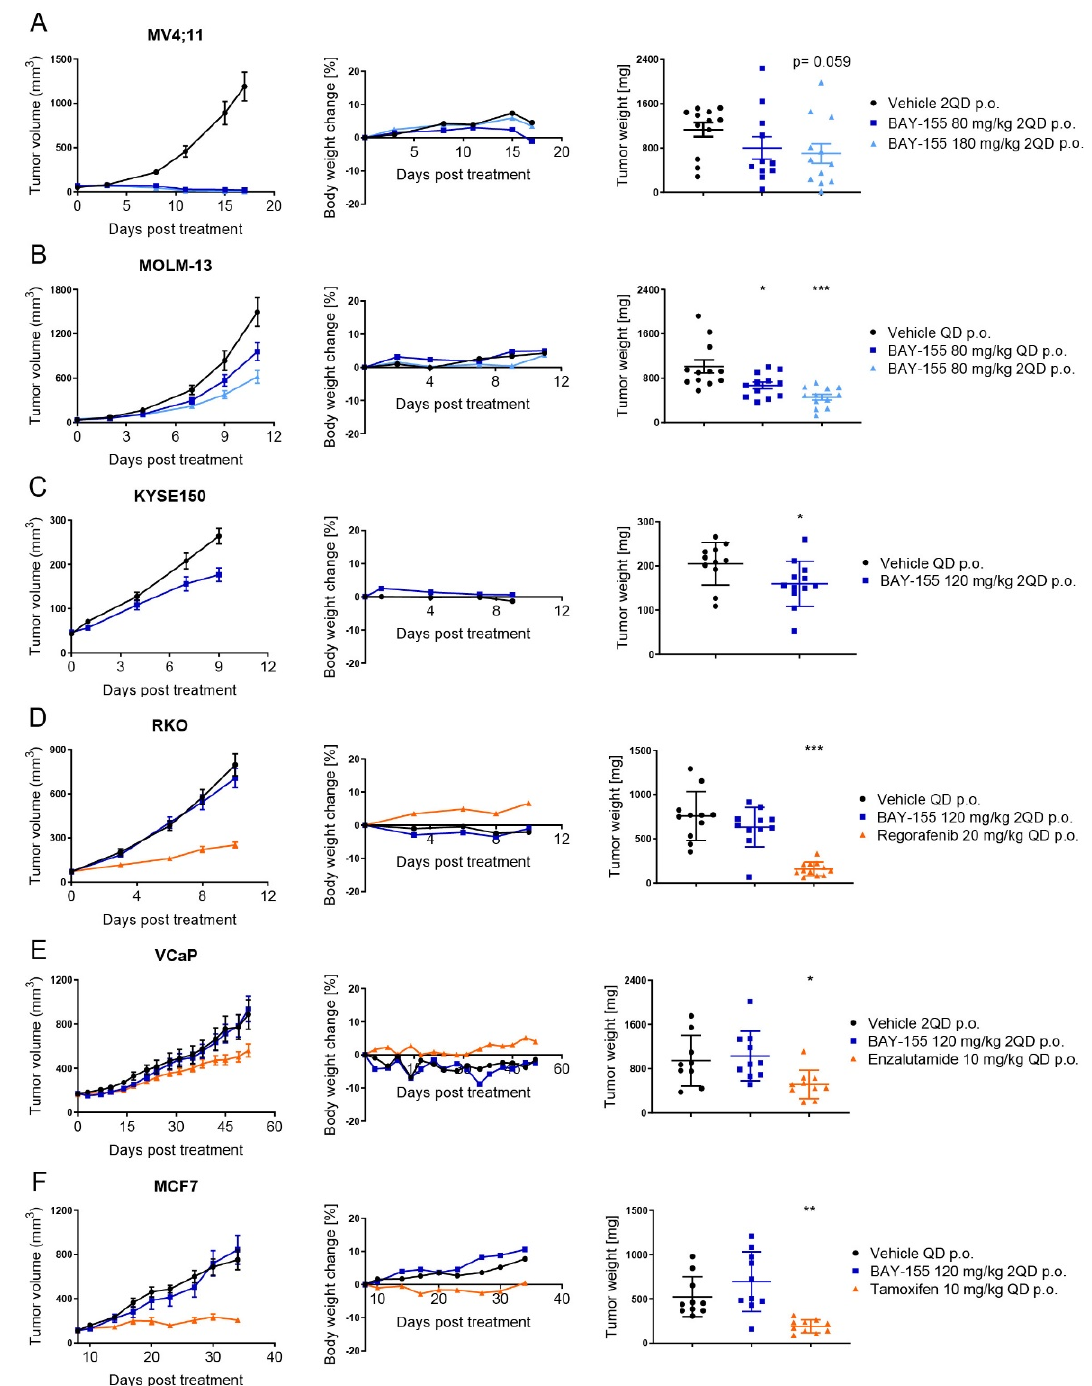
Figure 5. In vivo e ffi cacy of BAY-155 in various tumor models. Tumor volumes (left), body weight change (center) and tumor weights (right) in mice bearing subcutaneous ( A ) MV4;11, ( B ) MOLM-13, ( C ) KYSE150, ( D ) RKO, ( E ) VCaP, ( F ) MCF7 xenografts and treated once or twice daily with the indicated doses of BAY-155. RKO, MCF7 and VCaP xenografts were also treated with regorafenib, tamoxifen and enzalutamide at the indicated doses, respectively. The tumor weight was assessed at the end-point of the study; unpaired t -test with Welch’s correction was used for statistical testing. Data are presented as mean value ± SEM, n = 10 or 12 mice per group. Significant di ff erence between vehicle control and treatment group: * p -value ≤ 0.05; ** p -value ≤ 0.01; *** p -value ≤